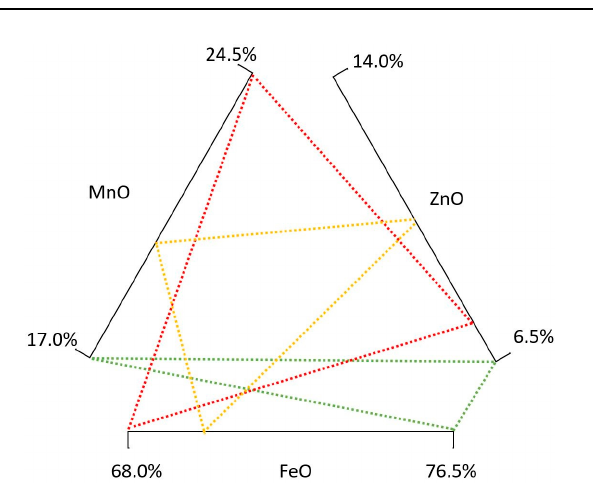
Figure 4. MnZn soft ferrite environmental impact diagram.